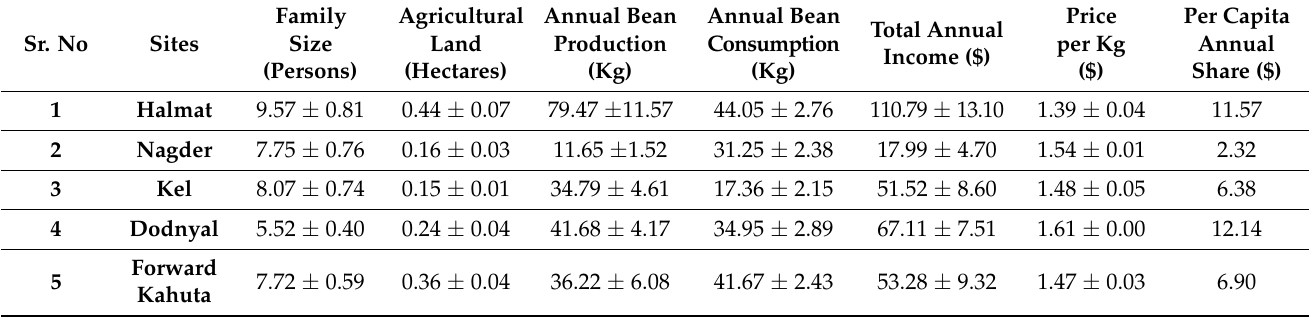
Table 2. Family size, agricultural land, common bean production, consumption and livelihood support recorded from bean producing villages of the AJK